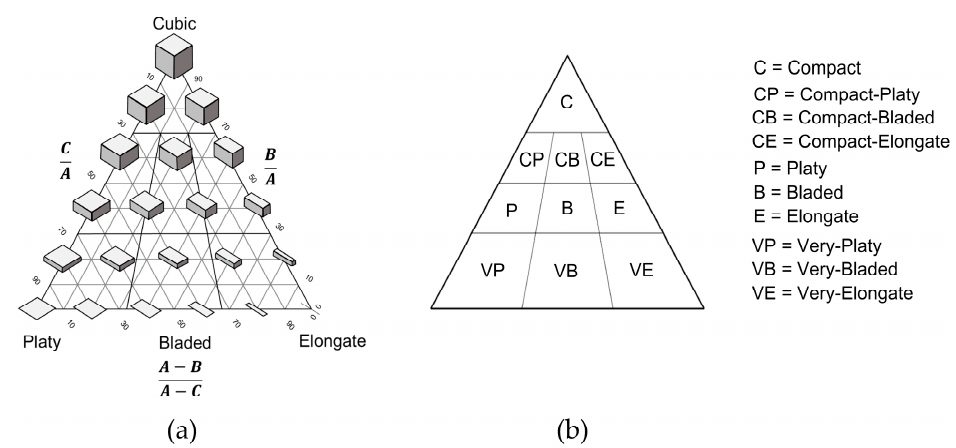
Figure 9. The Sneed and Folk ternary diagram, adapted from Blott and Pye [68]. ( a ) A visual representation of the different shapes on the depicted on the diagram. The relations between the shape axes A, B, and C are shown along each ternary axis; ( b ) The 10 classifications of shape, given by Sneed and Folk [69].